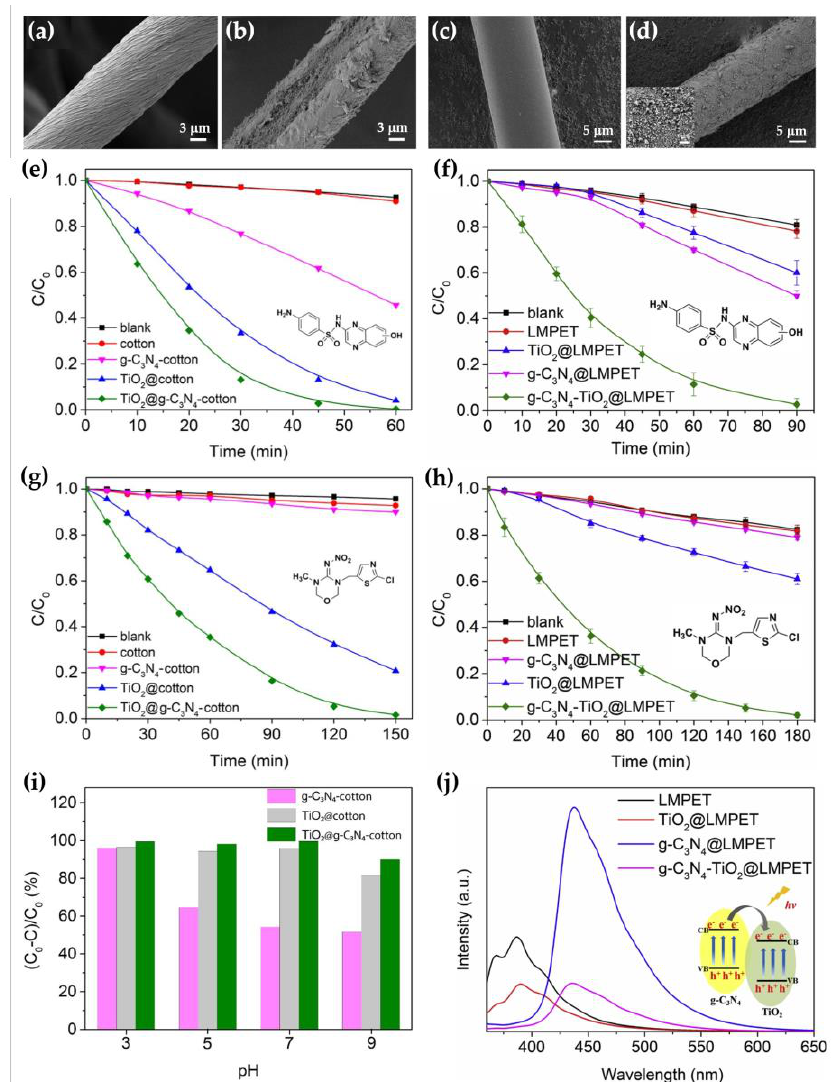
Figure 8. SEM images of cotton ( a ), TiO 2 @g-C 3 N 4 –cotton ( b ), LMPET ( c ), and g-C 3 N 4 -TiO 2 @LMPET